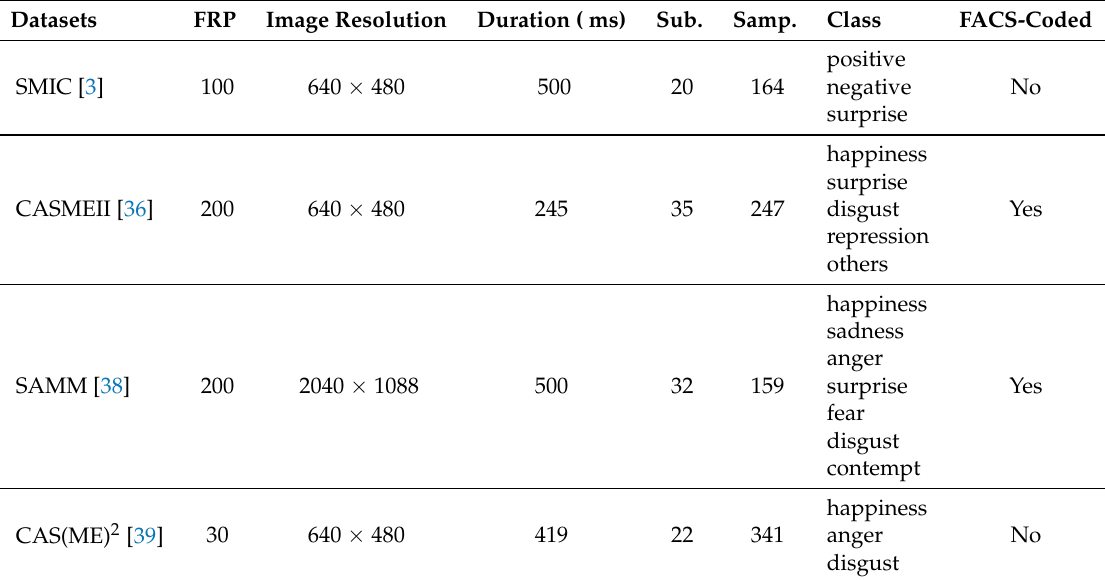
Table 4. Spontaneous ME Datasets used for